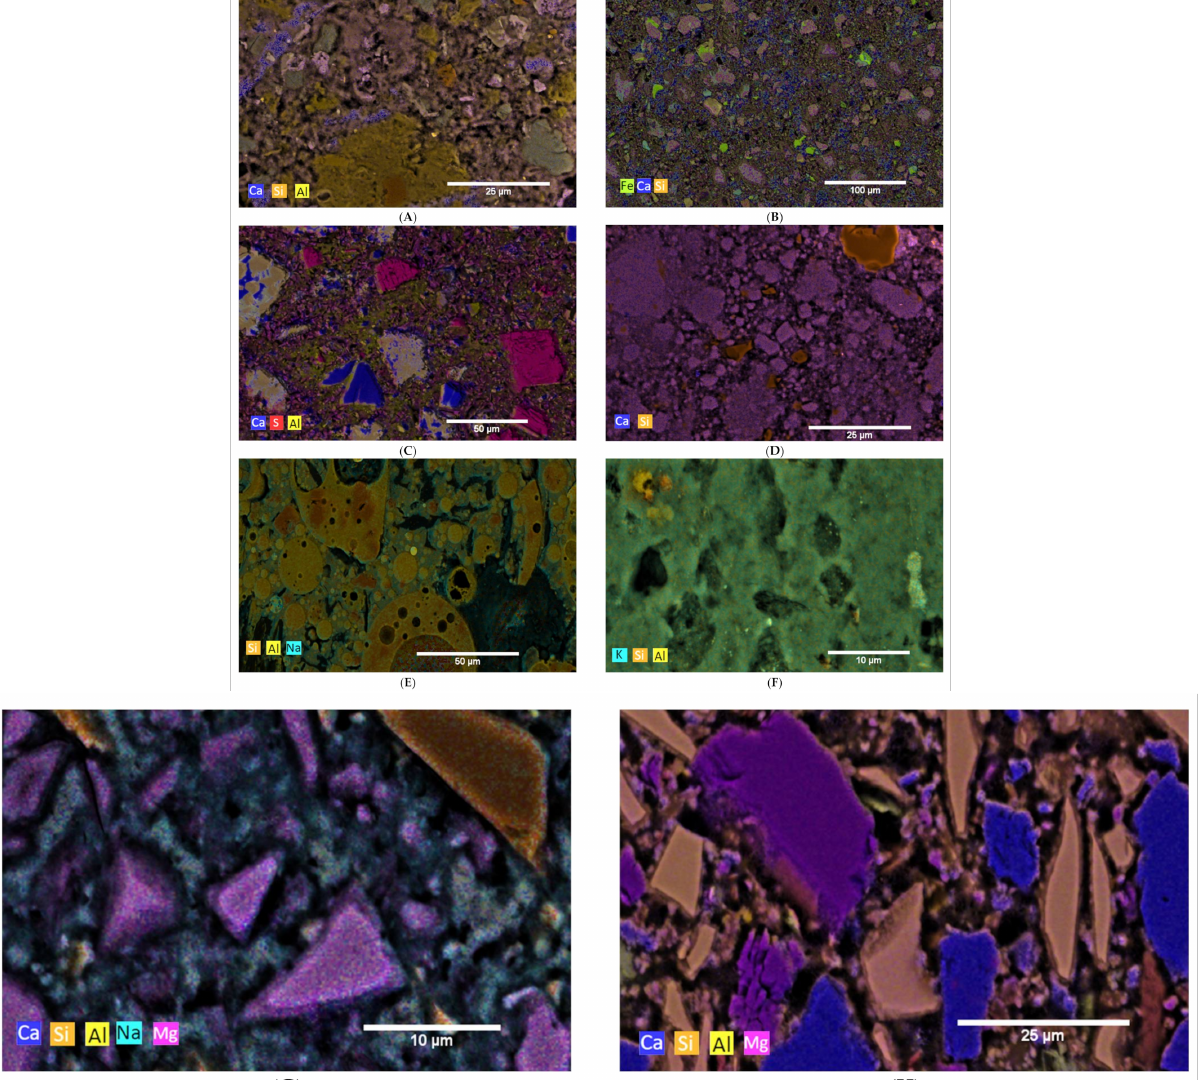
Figure 1. Layer images after seven days of hydration. ( A ) layer image CC I after 7 d hydration on paste samples; ( B ) layer image LD I after 7 d hydration on paste samples; ( C ) layer image CSA I after 7 d hydration on paste samples; ( D ) layer image C-S-H I after 7 d hydration on paste samples; ( E ) layer image Geo FA I after 7 d hydration on paste samples; ( F ) layer image Geo MK I after 7 d hydration on paste samples; ( G ) layer image AAS I after 7 d hydration on paste samples; ( H ) layer image AAS II I after 7 d hydration on paste